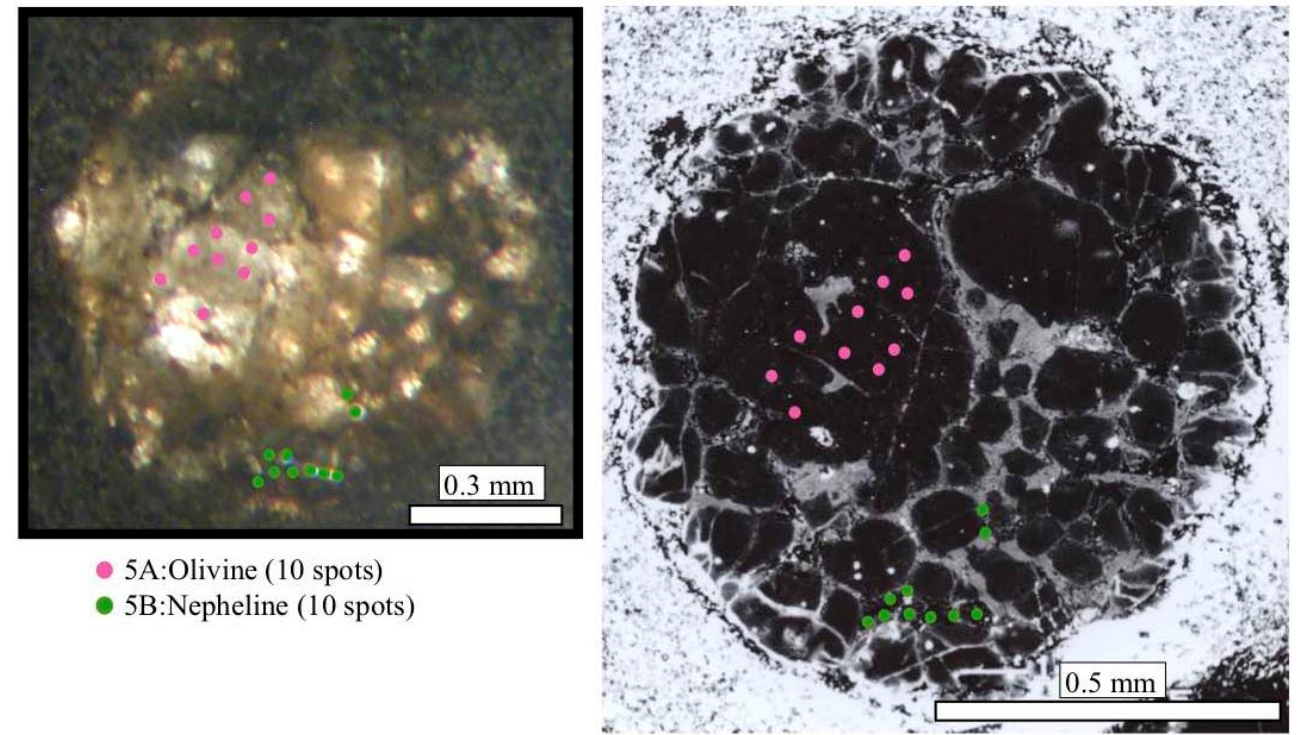
Figure 7. Optical view and BSE image of POC-6 showing laser shot locations. The number of laser spots is ten shots for the 5A olivine phase (pink) and for the 5B nepheline phase (green).